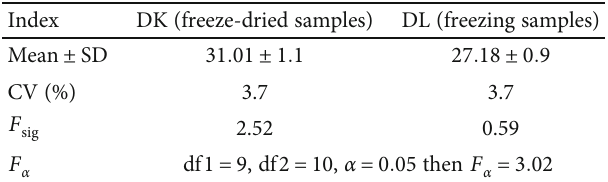
Table 3: Evaluating the homogeneity of the freeze-dried and freezing method